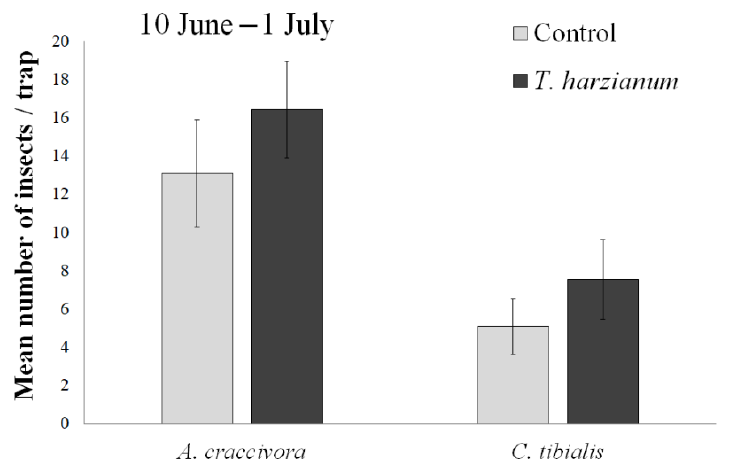
Figure 3. Presence of phytophages on yellow sticky traps. Mean values (± standard errors) of A. craccivora and C. tibialis individuals collected per trap for each treatment from 10 June to 1 July. For both A. craccivora and C. tibialis , no significant differences were found between treatments (F 1,12 = 0.82 and F 1,12 = 0.9, respectively) nor between experimental plots within treatments (F 4,12 = 1.77 and F 4,12 = 0.87, respectively). Even if not significant, the yellow sticky traps placed in the Trichoderma plots captured more A. craccivora and C. tibialis than the traps placed in the control